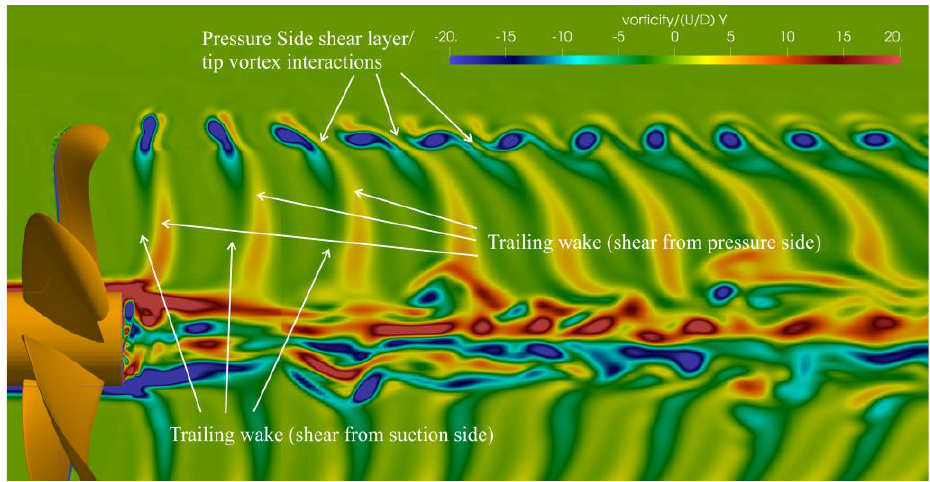
Figure 16. Longitudinal distribution of vorticity ( ω y ). New generation CLT propeller at the design advance coefficient ( J = 0.9).